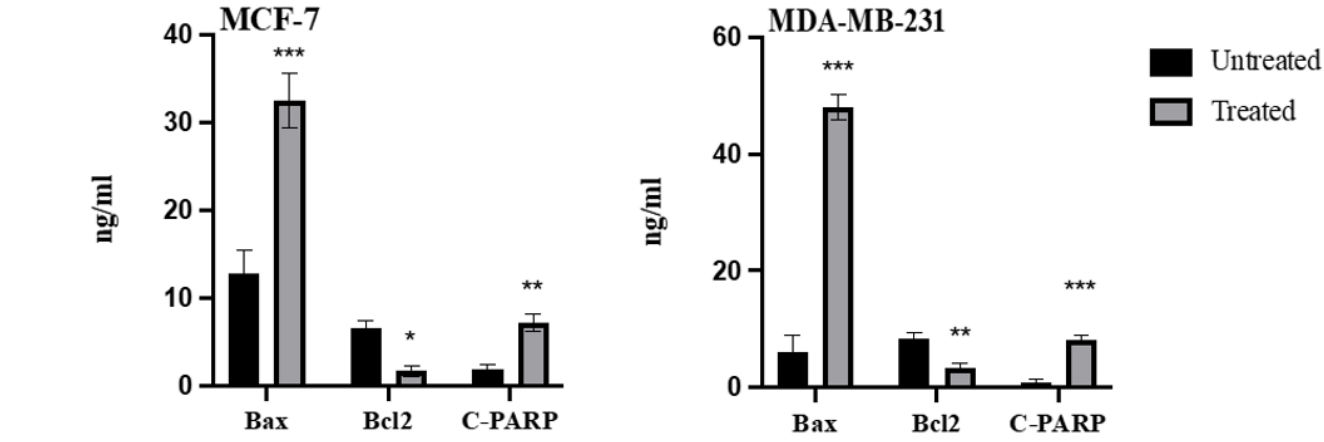
Figure 6. Effect of azilsartan on the levels of bax, bcl2 and c-PARP proteins. Bars represent mean ± SD, n = 3. Significant difference was analyzed by two-way ANOVA, where * p < 0.05, ** p < 0.01, *** p < 0.001, compared to untreated cells.